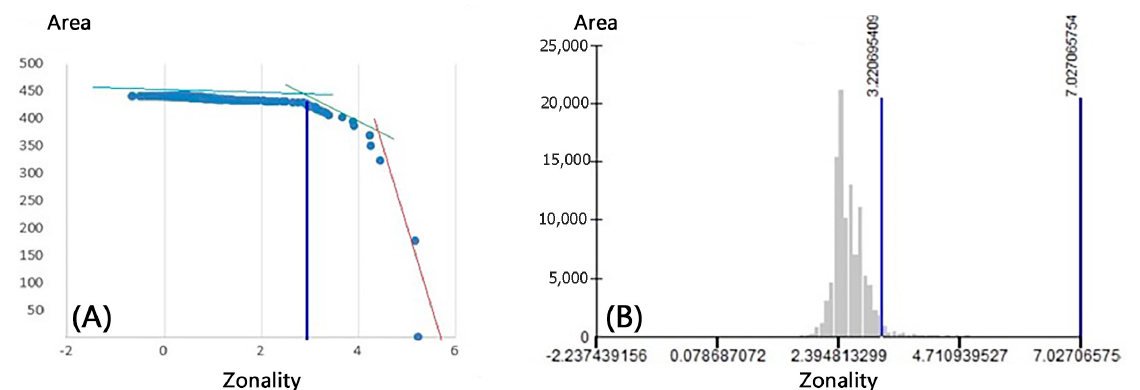
Figure 15. ( A ) Multifractal diagram of supra-mineral elements (Log(Pb*Zn*Bi) versus Log (area) for stream sediment samples); ( B ) Histogram of the calculated areas.